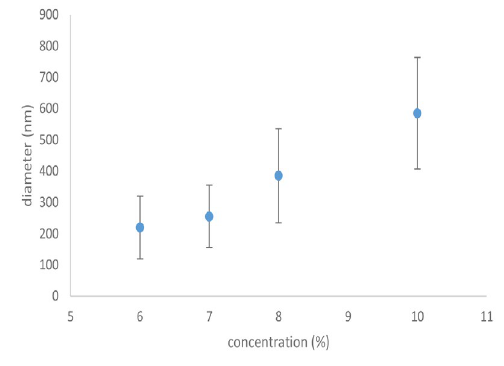
Fig. 1. The relation between concentrations to diameter of Cur- PCL nanofibers (6%, 7%, 8% and